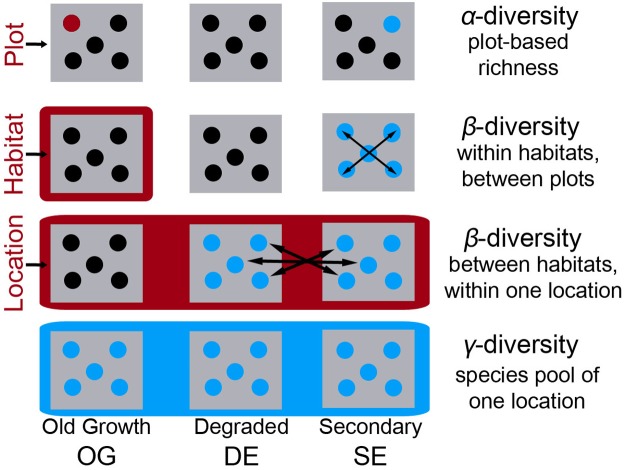
Schematic representation of the sampling design.We measured α-diversity in plots of 20 m x 20 m given as a mean of five plots. Five plots represent one habitat. We defined habitat as a homogenous type of forest-use intensity within one location. A location is representative of an elevational belt and harbors three different habitats (old-growth OG, degraded DE, and secondary SE). We measured two different β-diversities based on pairs of plots. Within-habitat β-diversity represents the compositional heterogeneity of a habitat. It is measured as the 1-Sørensen index based on multiple pairwise comparisons of the five plots within each habitat of a specific location. Between-habit β-diversity represents the compositional heterogeneity between different forest-use intensity. Measurement is similar to within-habitat β-diversity, but multiple pairwise comparisons based on the plots between habitats of a specific location. We defined γ-diversity as the total number of the local species pool across all 15 plots within a location, i.e. three habitats with five plots each.